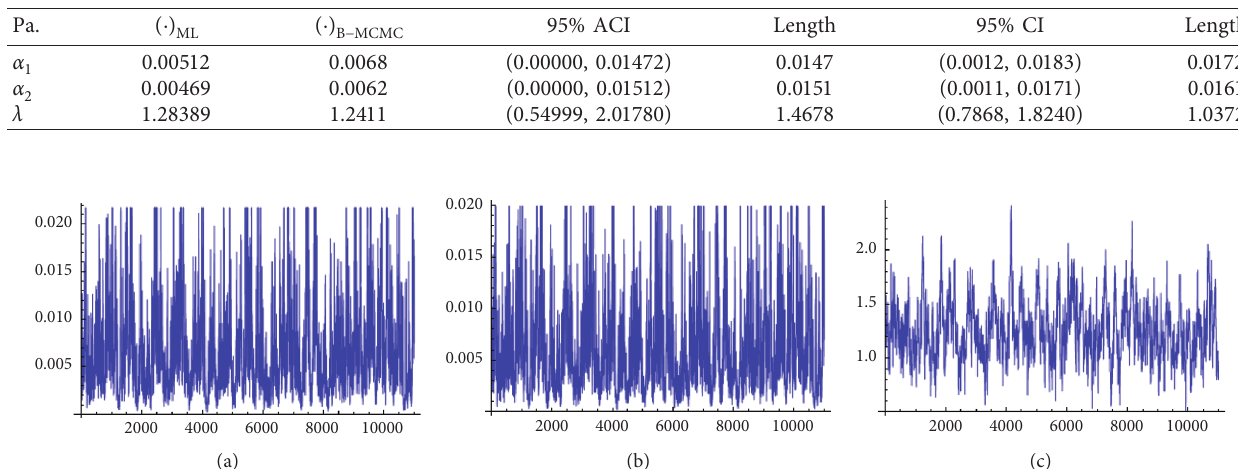
Figure 2: Profile log-likelihood function of λ . Table 2: Point and 95% interval ML and Bayes estimate.